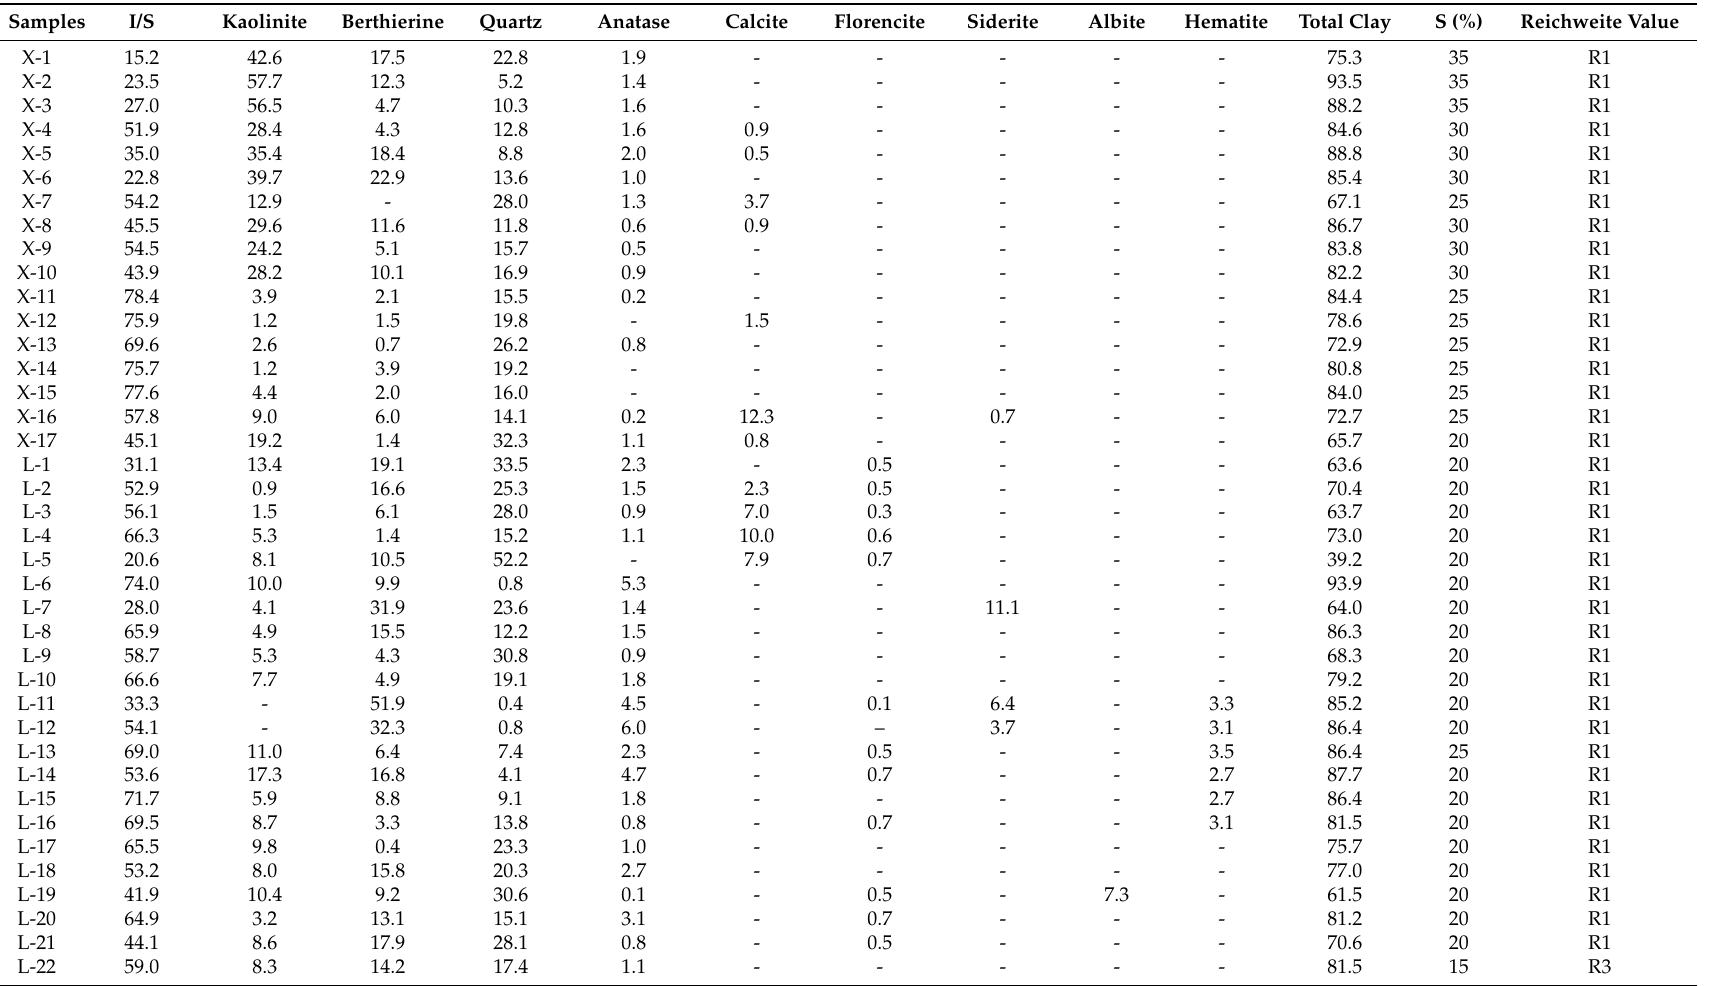
Table 1. Mineral contents (%) in the studied samples, and the estimated percentages of smectite layers i.e. , S (%) and Reichweite values for I/S. “-“ means below the detection limit of Siroquant